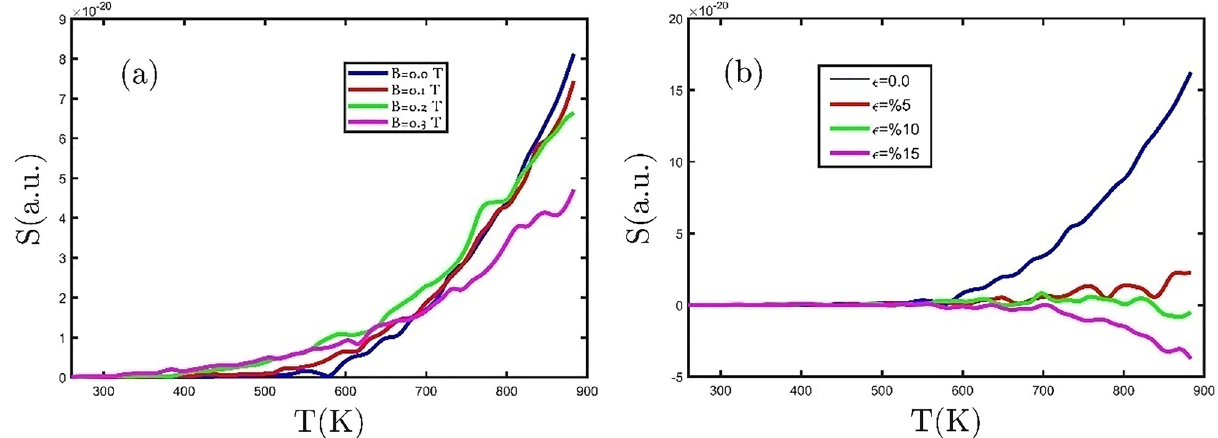
Figure 11. The Seebeck coefficient as a function of temperature ( a ) for different external magnetic field, and ( b ) for several tensile biaxial